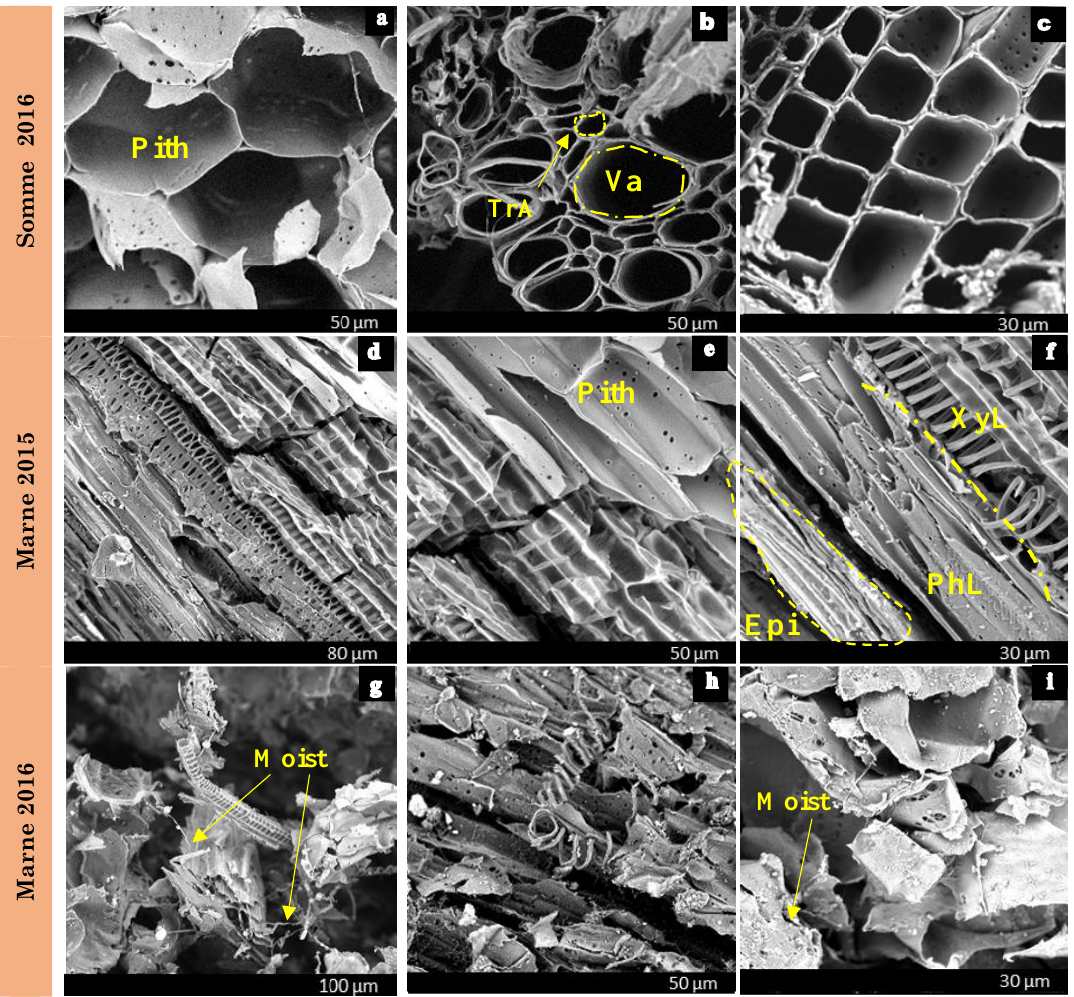
Figure 7. SEM micrographs of rape straws of Somme 2016 ( a – c ), Marne 2015 ( d – f ) and Marne 2016 ( g – i ).